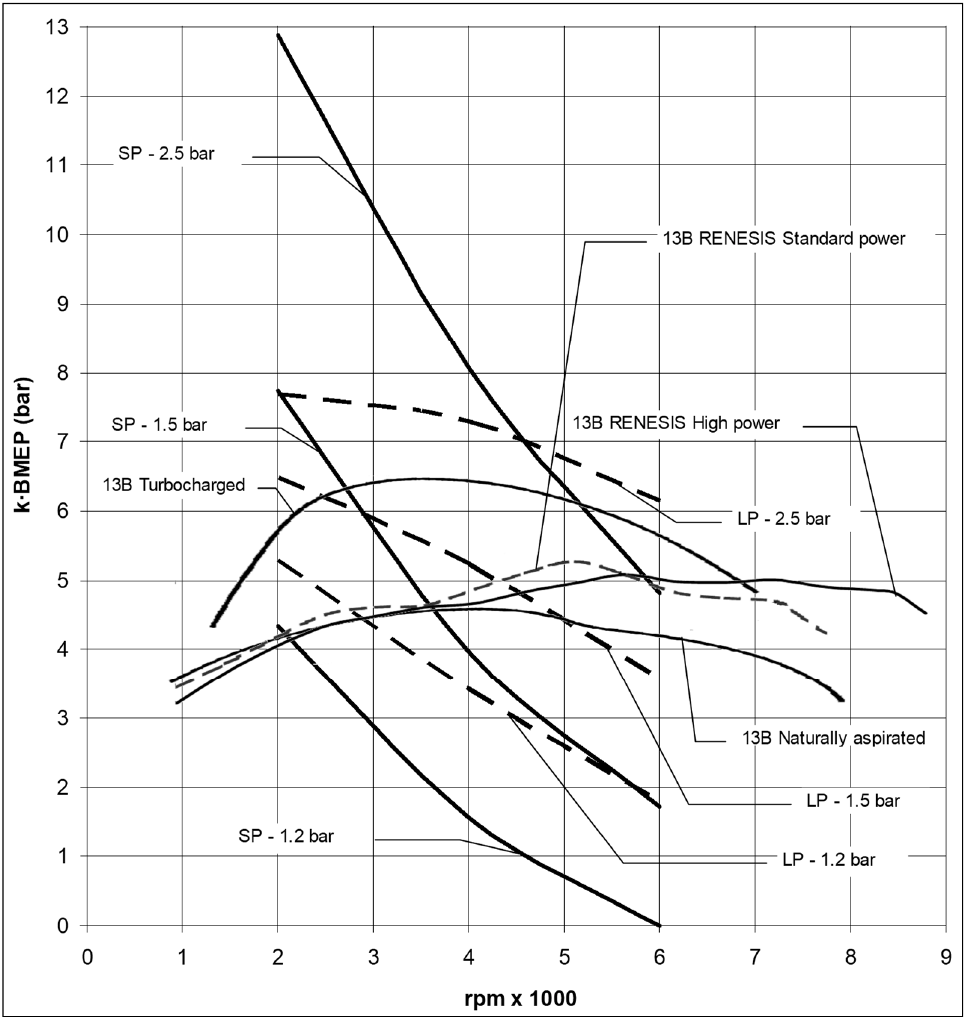
Figure 10. Comparison of mean effective work per stroke [6,41].